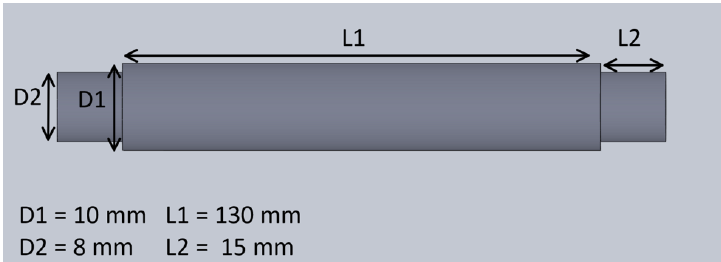
Figure 5. The dimensions of the hollow cylinders.